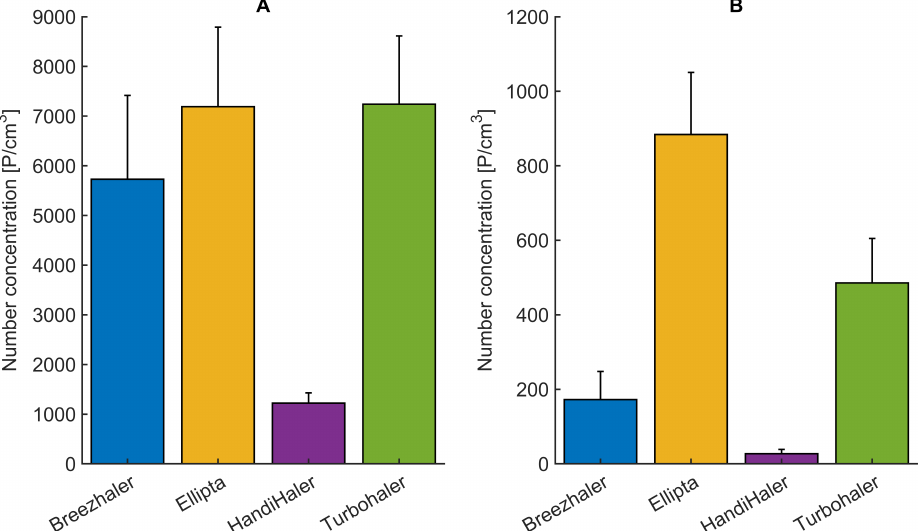
Figure 7. Differences between aerosol particle number concentration sampled from the air stream during ( A ) inhalation and ( B ) exhalation for four commercial DPIs. Respiration parameters are provided in Table